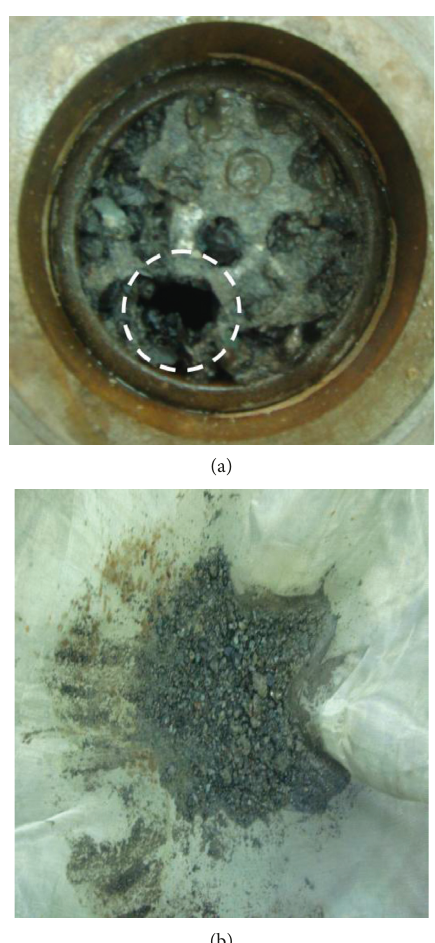
Figure 10: Specimen after seepage instability. (a) Water channel after seepage instability and (b) particles out of the